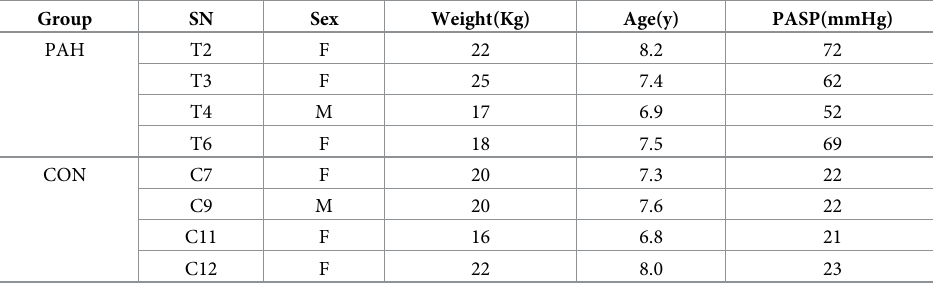
Table 1. Clinical characteristics of the